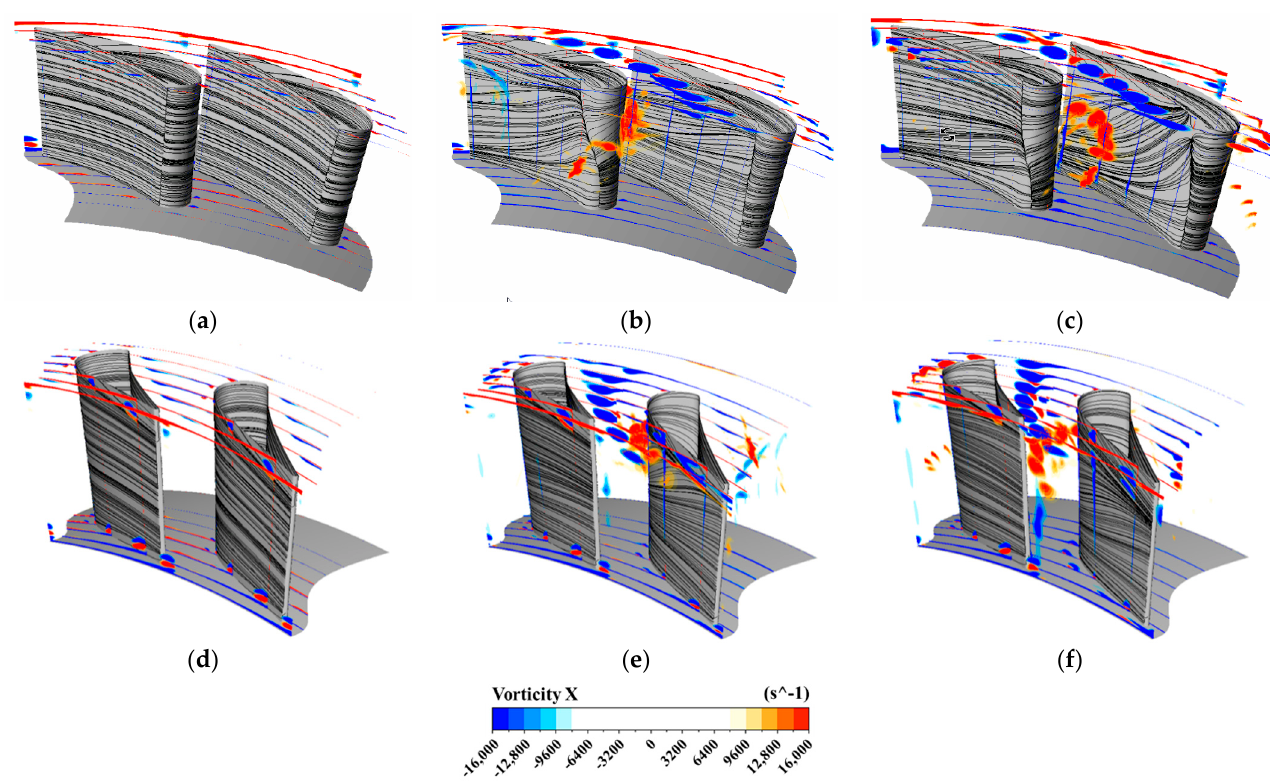
Figure 20. Comparison of vortex structure due to the swirl clocking − SL0 SP0 model (Baseline): ( a ) No swirl (front view); ( b ) SW@LE (front view); ( c ) SW@PC (front view); ( d ) No swirl (rear view); ( e ) SW@LE (rear view); ( f ) SW@PC (rear view).